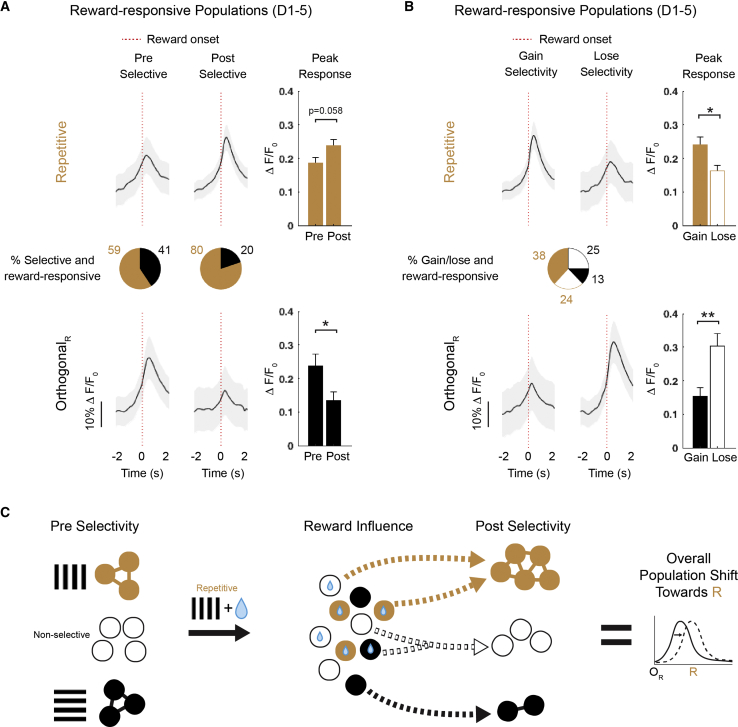
Generalization of Reward-Associated Activity across V1 Subpopulations and Viewing Contexts(A) Average activity (ΔF/F0) across trials for all animals that received rewards; activity associated with reward onset (time = 0; ±2-s window) is shown as traces, averaged over neurons in selected populations: reward-responsive and selective for the R grating (orange) on either pre (n = 108) or post (n = 150) testing days (top) or reward responsive and selective for the orthogonal to the R grating (orthogonalR; black) on either pre (n = 74) or post (n = 37) testing days (bottom). Proportion of total for these populations is shown as pie charts for pre and post days. Average peak response (max ΔF/F0 within window) for these populations is shown on right (repetitive selective: p = 0.058; orthogonal selective: p = 0.023; Student’s t test).(B) Average activity (ΔF/F0) across trials for all animals that received rewards; activity associated with reward onset (time = 0; ±2-s window) is shown as traces, averaged over neurons in selected populations: reward-responsive and gained selectivity (n = 113; solid orange) or lost selectivity (n = 71; open orange) for the R grating on post testing day (top) or reward responsive and gained selectivity (n = 38; solid black) or lost selectivity (n = 74; open black) for the orthogonalR on post testing day (bottom). Proportion of total for these populations is shown as pie chart. Average peak response (max ΔF/F0 within window) for these populations is shown on right (repetitive: p = 0.010; orthogonal selective: p = 0.001; Student’s t test).(C) Summary schematic of conditions underlying generalization of reward-associated activity across environmental contexts and days. Populations selective for the R grating (orange), orthogonalR (black), and non-selective (white) are indicated. Stimulus-associated reward influences shift V1 populations responses toward the R grating on the post testing day.All panels: ∗p < 0.05; ∗∗p < 0.01; ∗∗∗p < 0.001; error bars: SEM.